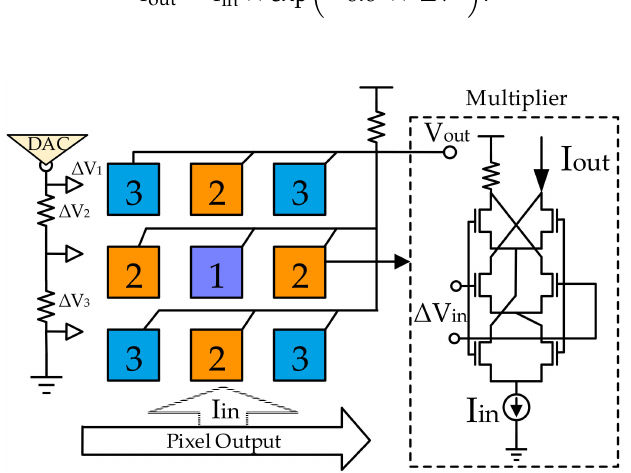
Figure 5. Gaussian convolution unit in analog signal